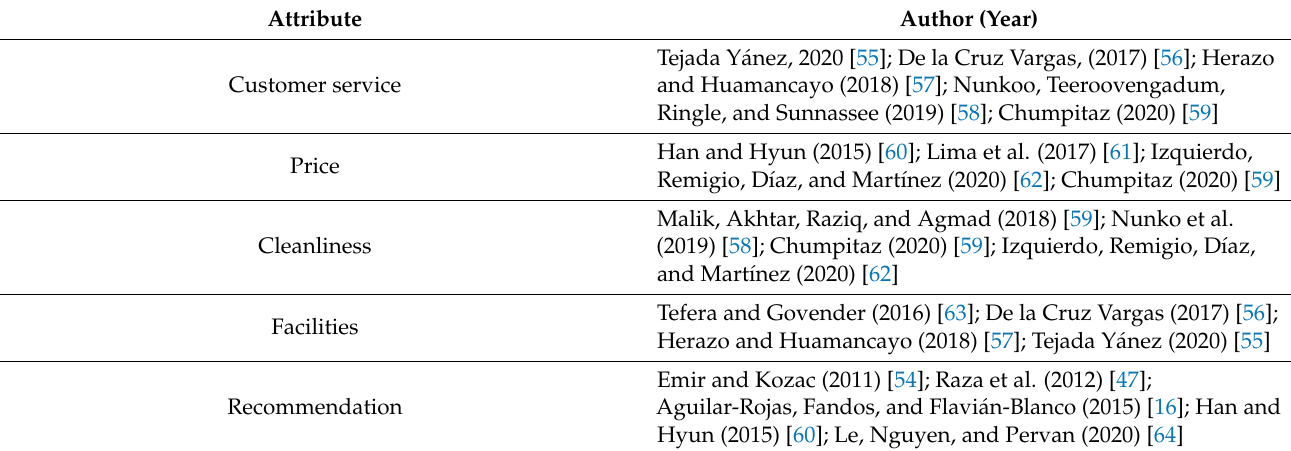
Table 1. Review of the use of service satisfaction assessment